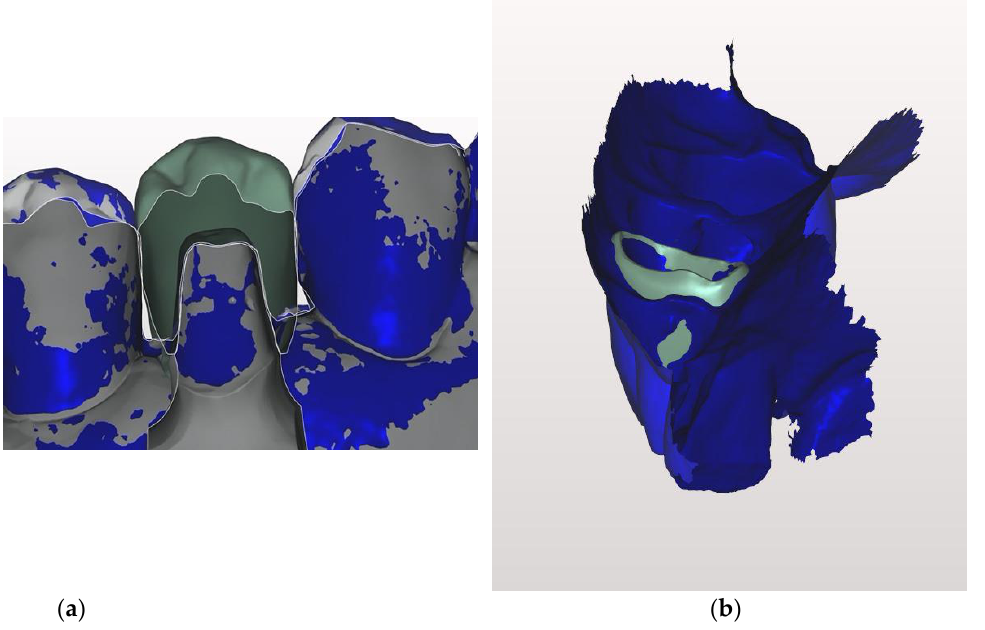
Figure 6. After waxing up the two crowns it is evident the difference in depth ( a , b ).